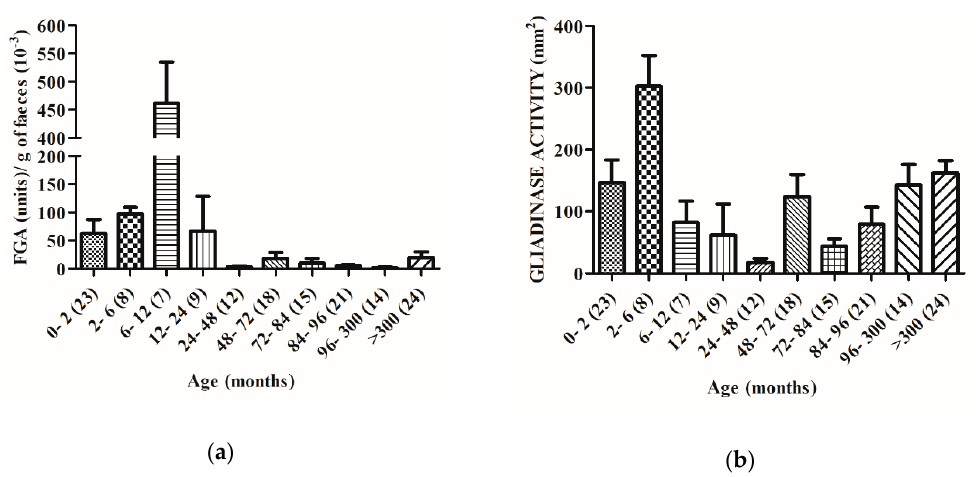
Figure 3. Gluten metabolism in all age range volunteers. ( a ) Glutenase bioassay results of fecal samples from 151 volunteers grouped by age ranges. Data represented as the mean ± SEM in terms of the number of units of trypsin / g feces of each age group. ( b ) Gliadinase activity evaluated by zymography and quantified by densitometry of the hydrolytic areas. Data are represented as the mean ± SEM in terms of the hydrolytic areas in mm 2 . Brackets reflect the number of volunteers of each age group. Interaction of age with glutenase and gliadinase activities is shown by two way ANOVA ( p = 0.0001).